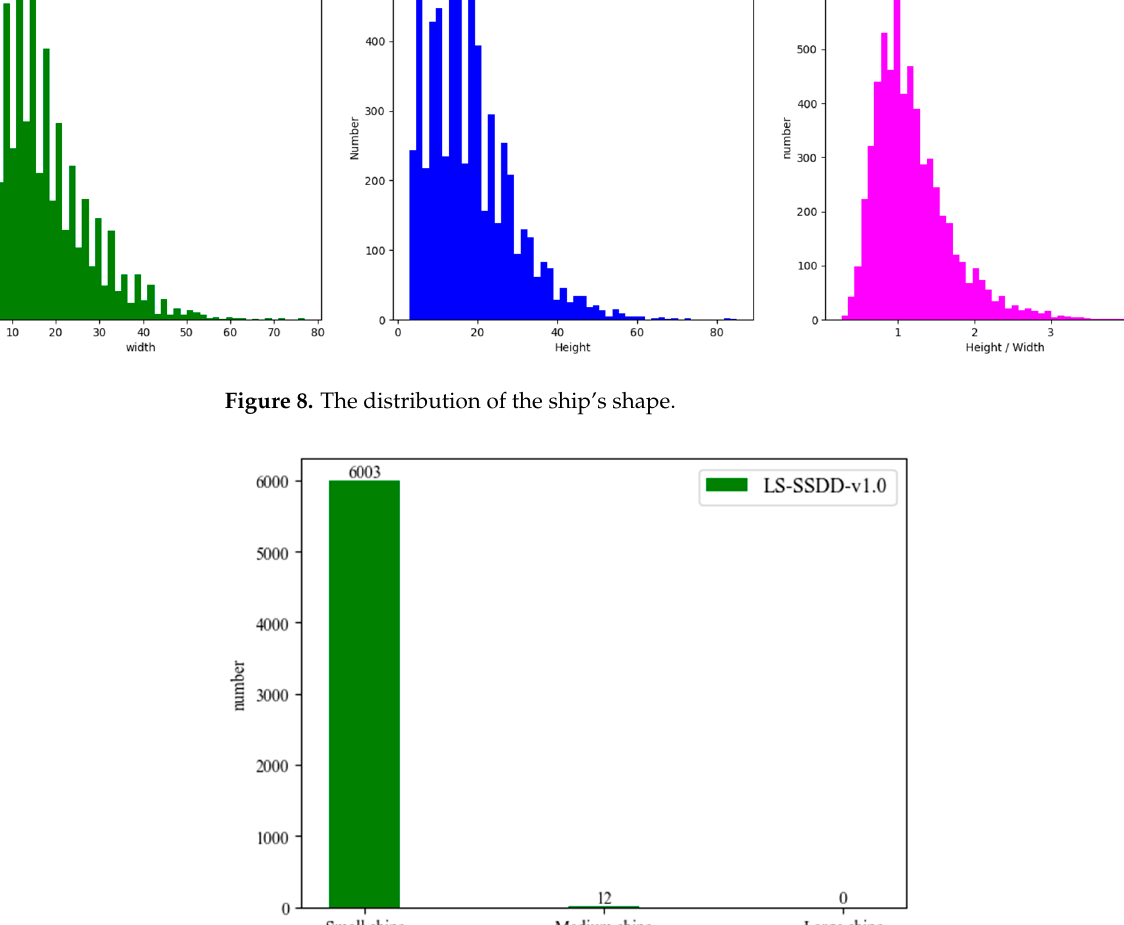
Figure 9. The distribution of the ship’s number.